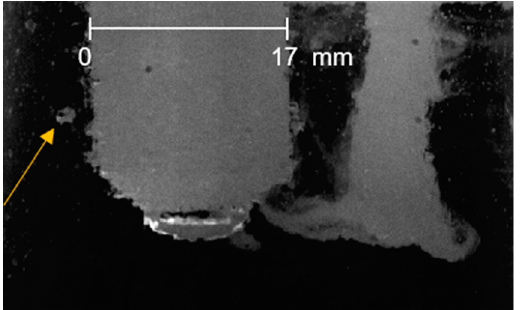
Figure 10. One small bubble detaching from the surface (yellow arrow pointing) while one large bubble growing at the surface during electrolysis at a constant cell voltage of 2.0 V. Average current density was 0.7 A cm − 2 . A scale bar is shown.